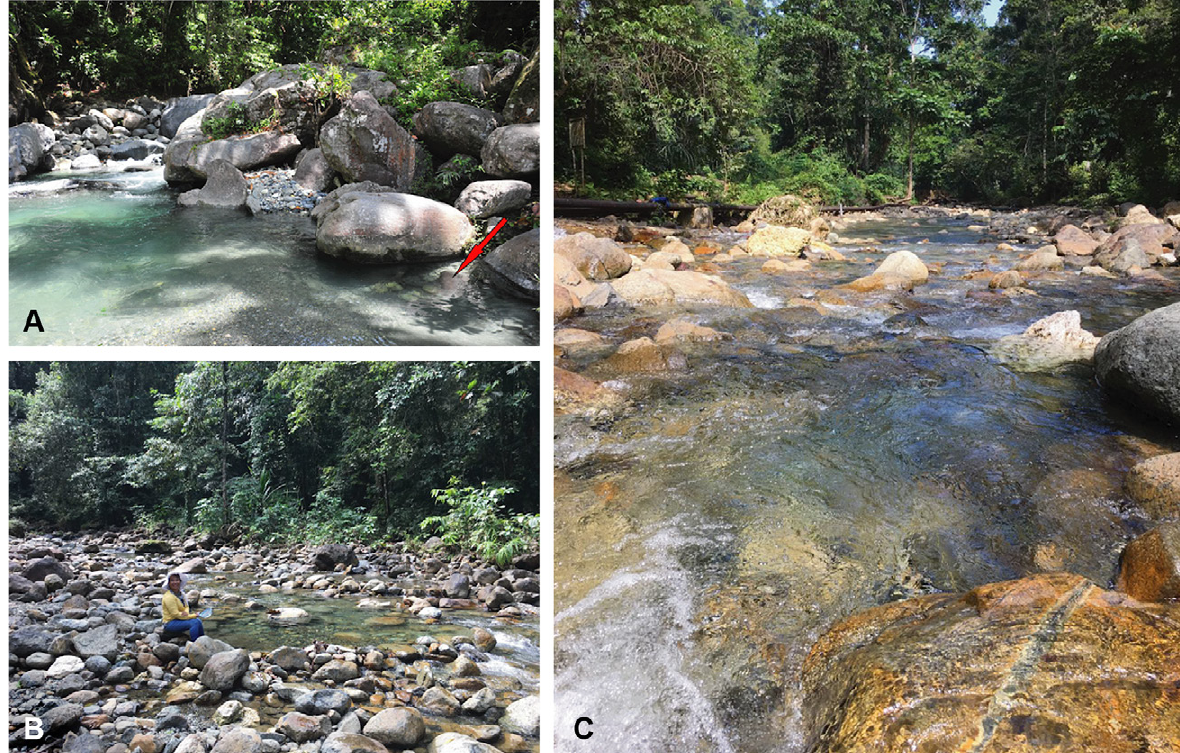
Figure 3. Dineutus helleri stueberi . Habitat. A. Mount Ifar. B, C. Kamp